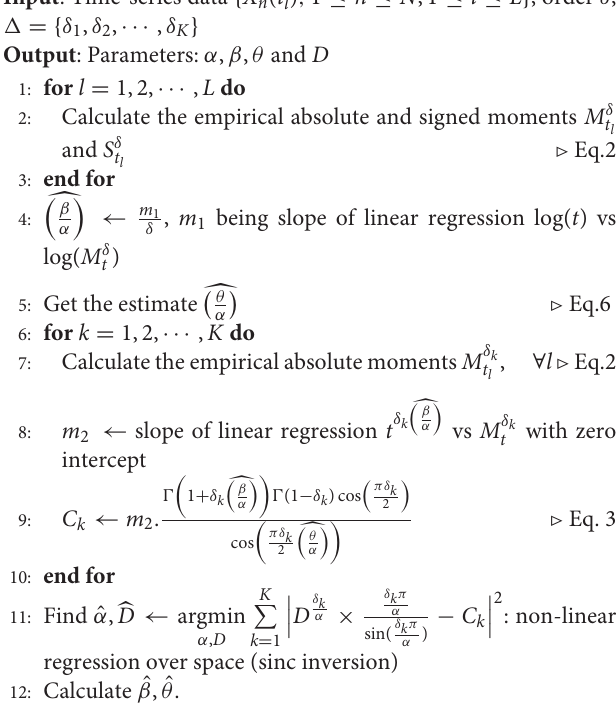
Algorithm 1: | Space-Time Fractional Diffusion: Parameters Estimation